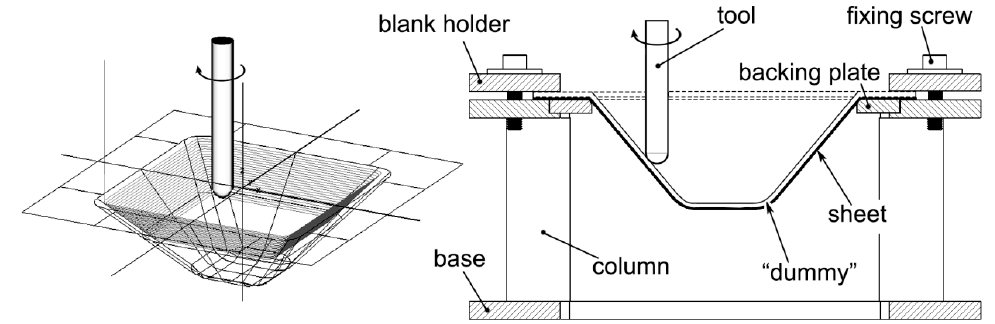
Figure 1. Schematic representation of SPIF process.